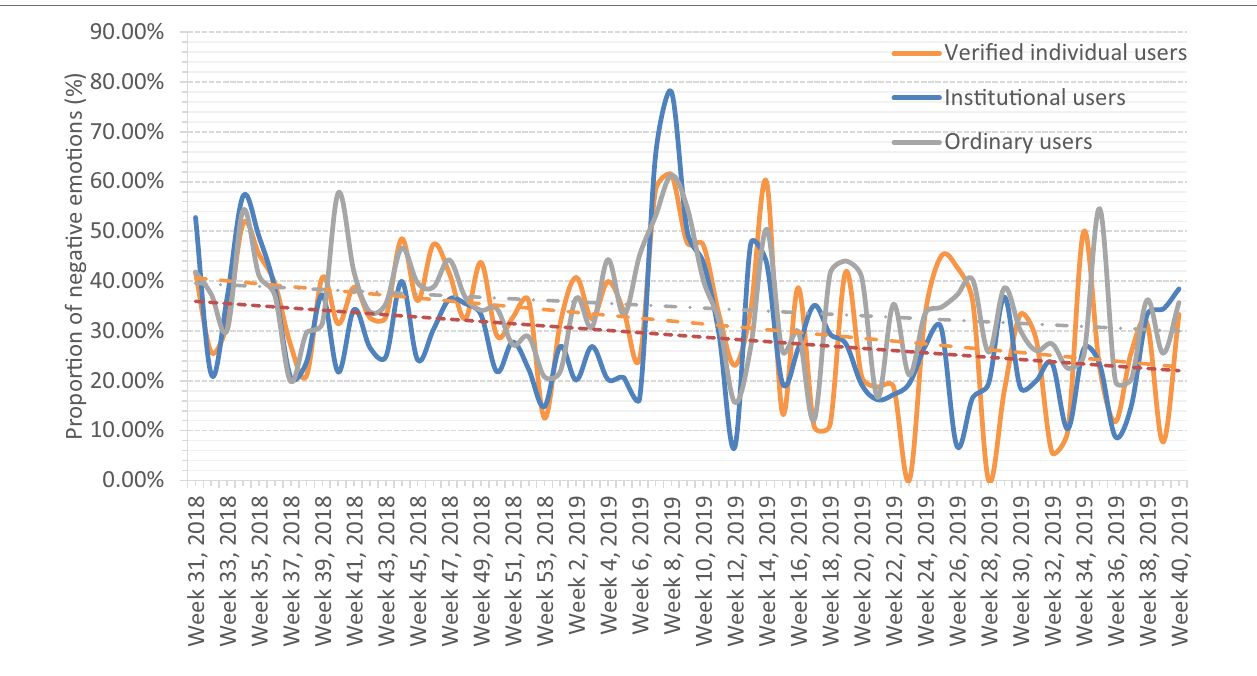
FIGURE 7 | Negative emotion